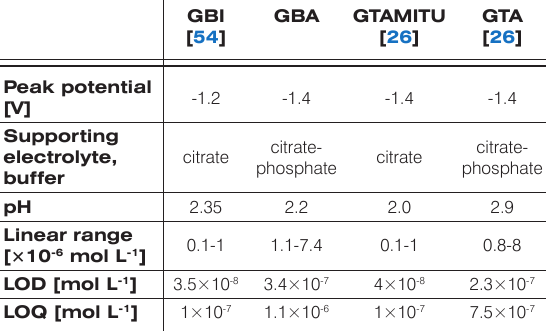
Table 3. Results of SW voltammetric determination of guanidine compounds at